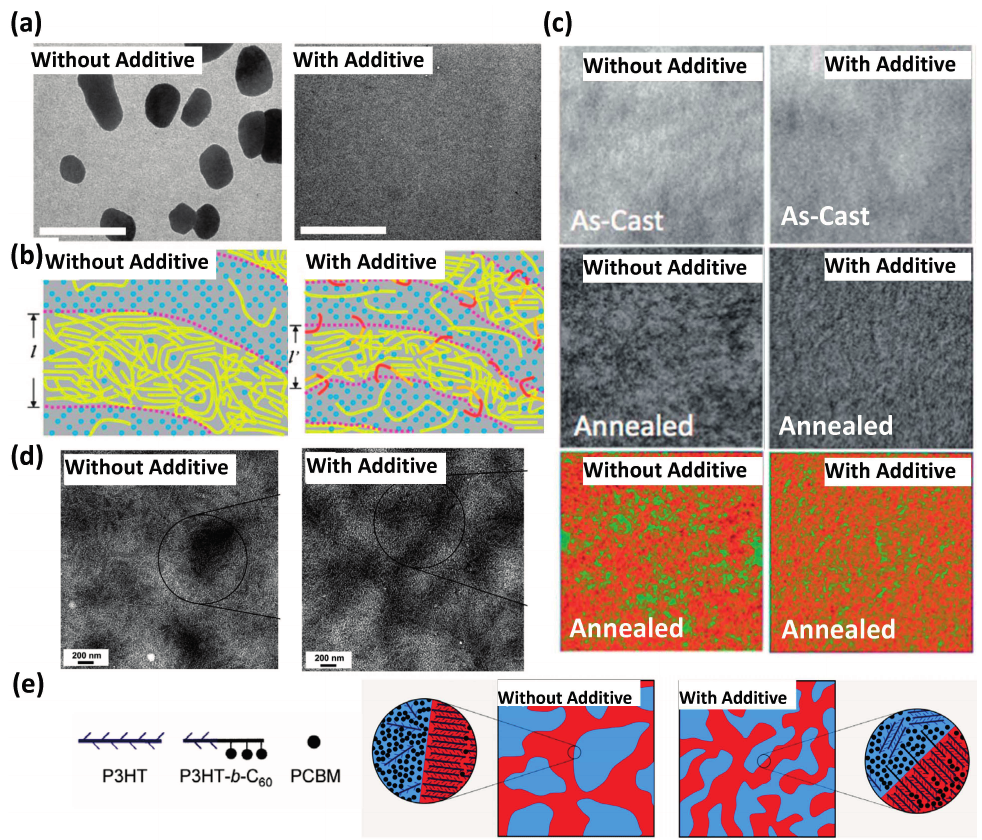
Figure 2. ( a ) TEM (Transmission electron microscope) images of P3HT/PC 61 BM with and without 17 wt% diblock copolymer. The scale bar is 2 μ m; ( b ) Illustration of P3HT/PC 61 BM without and with 10% additive P3HT- b -PEO; ( c ) P3HT mapping obtained from energy filtered TEM images before (top) and after (middle) thermal annealing for P3HT/PC 61 BM blend films without and with 10% P3HT- b -PEO respectively. The bottom row images are the color-scaled middle row images in which the green color represents the P3HT-rich domains; ( d ) TEM images of P3HT/PC 61 BM blend films without and with 2.5% P3HT- b -C 60 additive; and ( e ) Schematic representations of P3HT/PC 61 BM blend